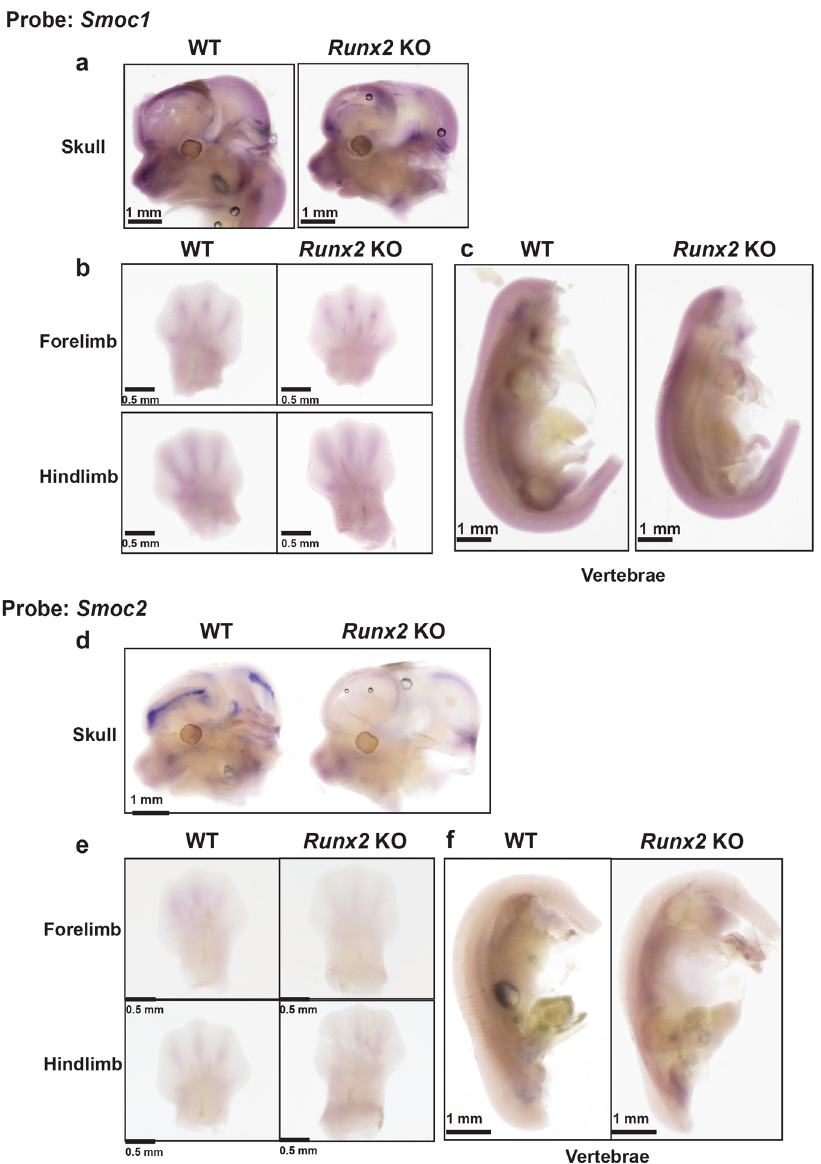
Fig. 2 Expression of Smoc1 and Smoc2 in skeletal tissues. Whole-mount in situ hybridization analyses of ( a ) skull, ( b ) forelimb and hindlimb, and ( c ) vertebrae in Runx2 KO and WT littermate mice at E12.5 for Smoc1 . Whole-mount in situ hybridization analyses of ( d ) skull, ( e ) forelimb and hindlimb, and ( f ) vertebrae in Runx2 KO or WT littermate mice at E12.5 for Smoc2 ( n = 4, biologically independent